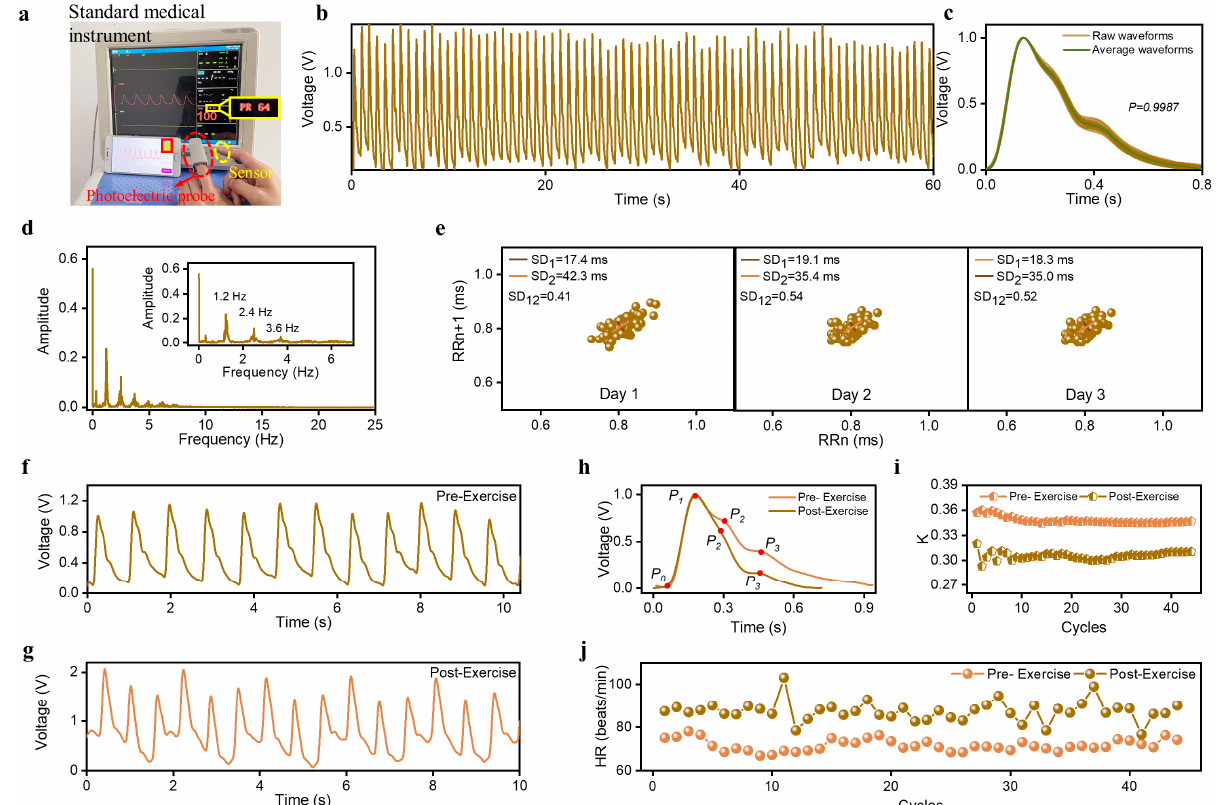
Figure 4. Human pulse wave monitoring. ( a ) Pulse wave monitoring by standard medical instrument and sensors simultaneously. ( b ) Continuous pulse wave monitoring for 1 min. ( c ) Consistency of pulse signals measured within 1 min. ( d ) The frequency spectrum of a 27-year-old woman’s radial artery pulse signals. ( e ) Pulse signal monitoring for continuous 3-day cycle. ( f ) The pulse wave monitoring before exercise. ( g ) The pulse wave monitoring after exercise. ( h ) The enlarged view of one cycle pulse signal measured before and after exercise. ( i ) Change of the K value before and after exercise. ( j ) Change of the HR before and after exercise.